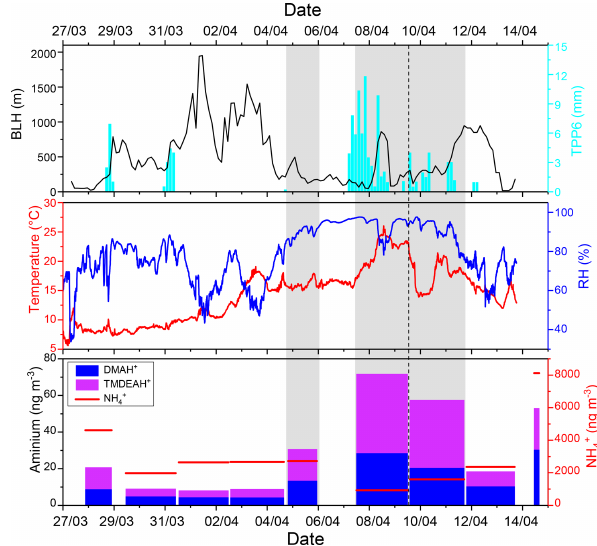
Figure 4. Time series of meteorological parameters and the concen- trations of aminiums and NH + during the 2017 spring cruise. The 4 time range spanned by the column of each aminium concentration corresponds to the sampling